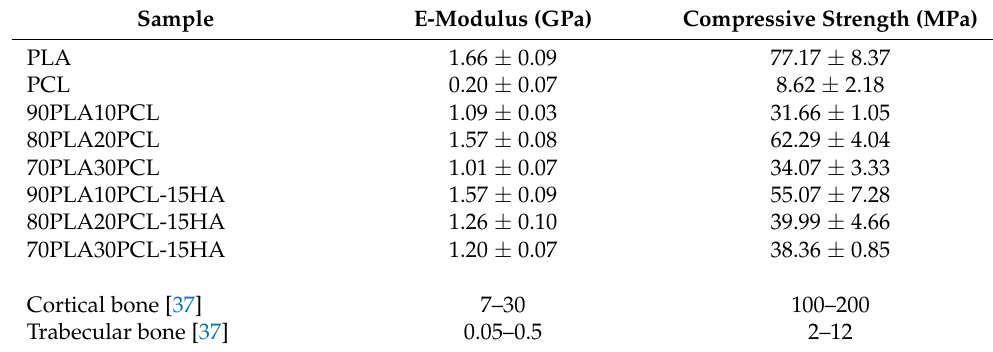
Table 4. Elastic modulus and compressive strength for all different materials obtained from compres- sion tests as well as reference values of human bone